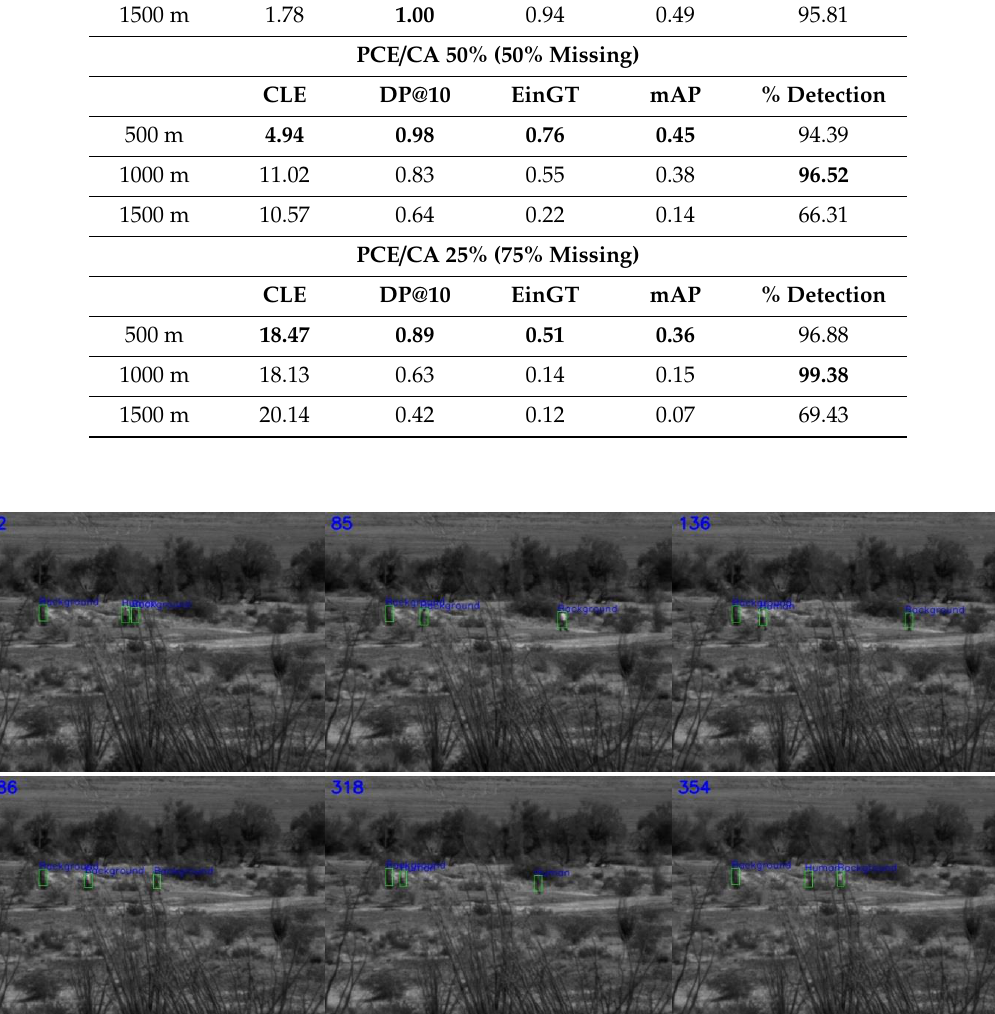
Table 1. Detection using optical videos. Bold numbers indicate the best results among the different ranges. Bold numbers indicate the best metric among all the ranges.